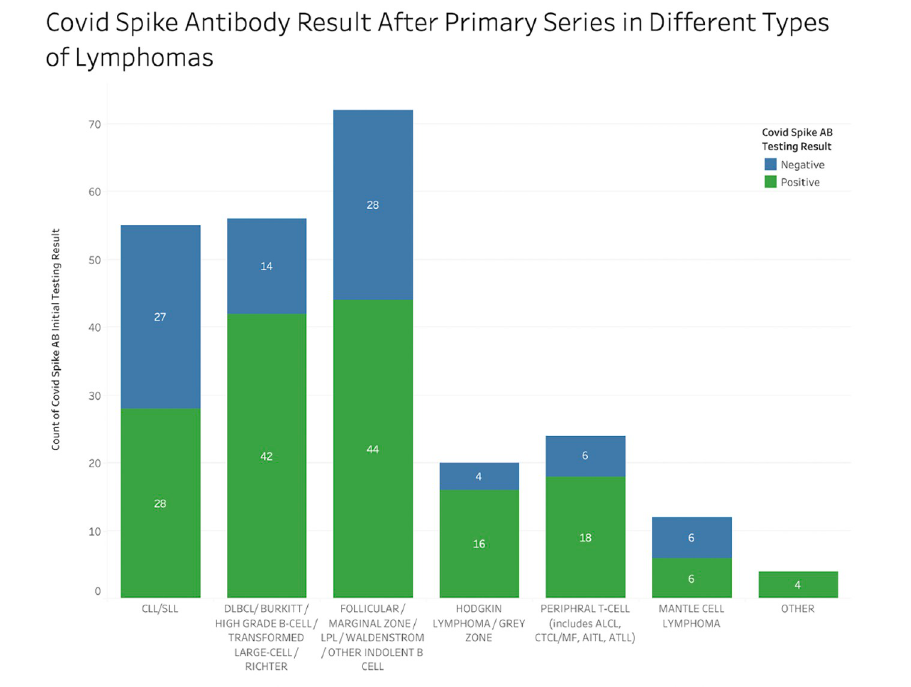
Fig 2. Serologic response against COVID spike protein after primary vaccination series by lymphoma